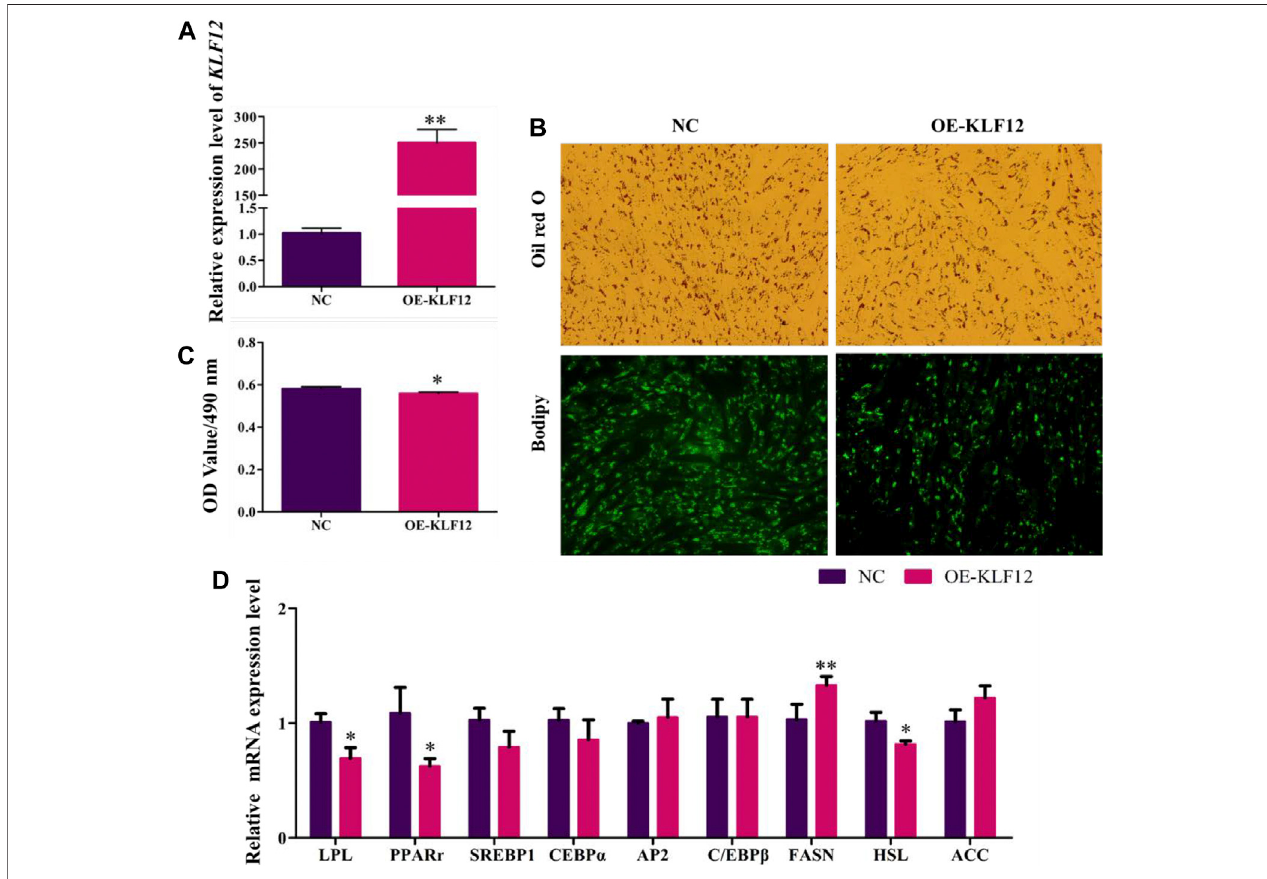
FIGURE 6| Overexpression of KLF12 inhibited goat preadipocyte differentiation. (A) Ef fi ciency ofOE- KLF 12. (B) Oilred O staining and Bodipy staining ( × 200). (C) OD value at 490 nm. (D) mRNA expression levels of key adipogenic regulatory genes after overexpression of KLF12.